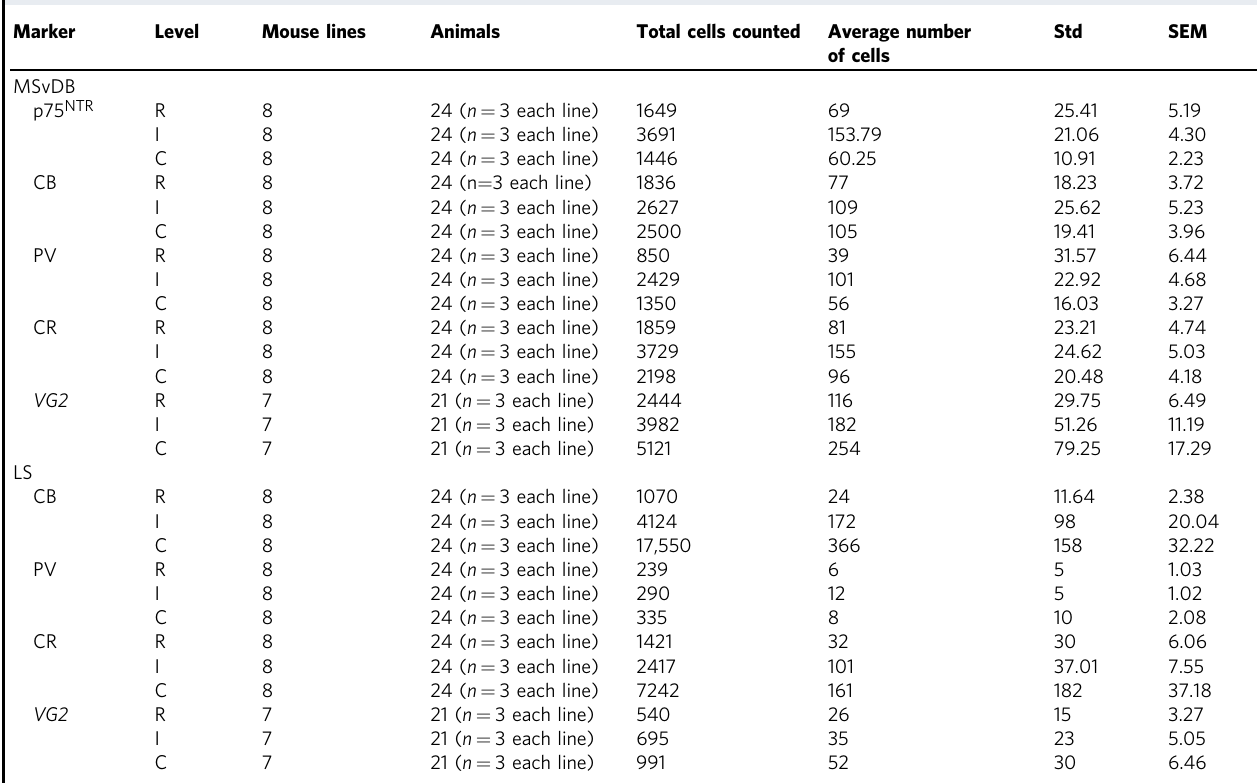
Table 1 Cells counted in the MSvDB and the LS.